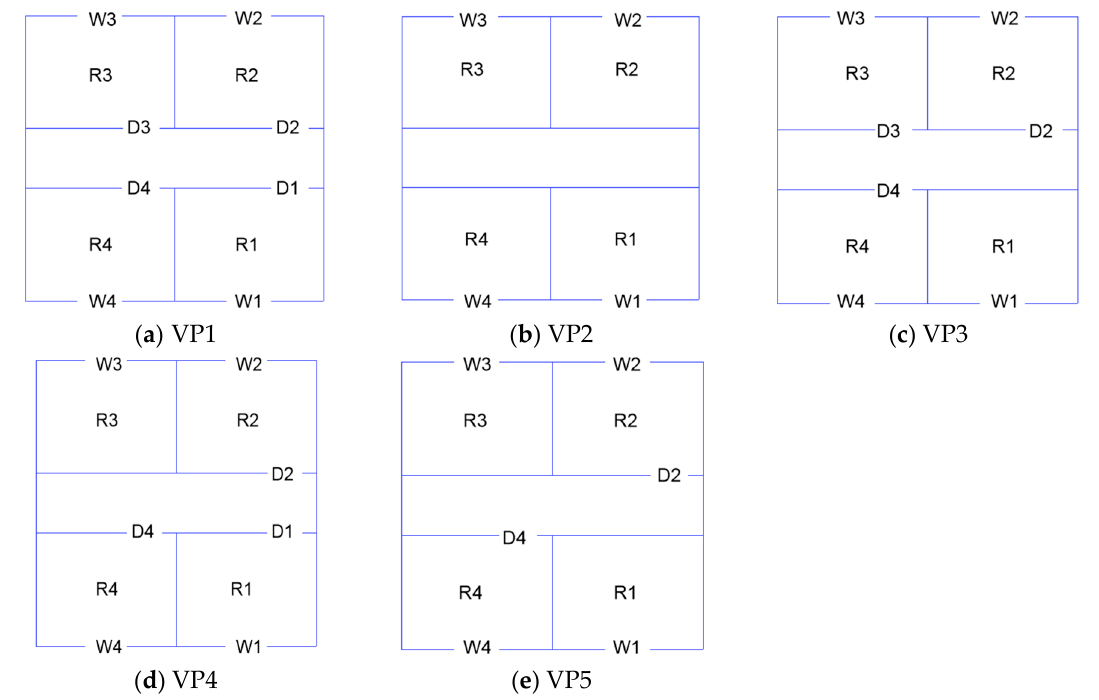
Figure 6. Five typical ventilation paths. ( a ) Ventilation path 1 (VP1); ( b ) Ventilation path 2 (VP2); ( c ) Ventilation path 3 (VP3); ( d ) Ventilation path 4 (VP4); ( e ) Ventilation path 5 (VP5).